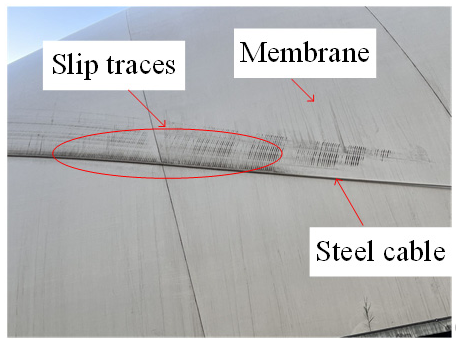
Figure 2. Friction slip between cable and membrane.